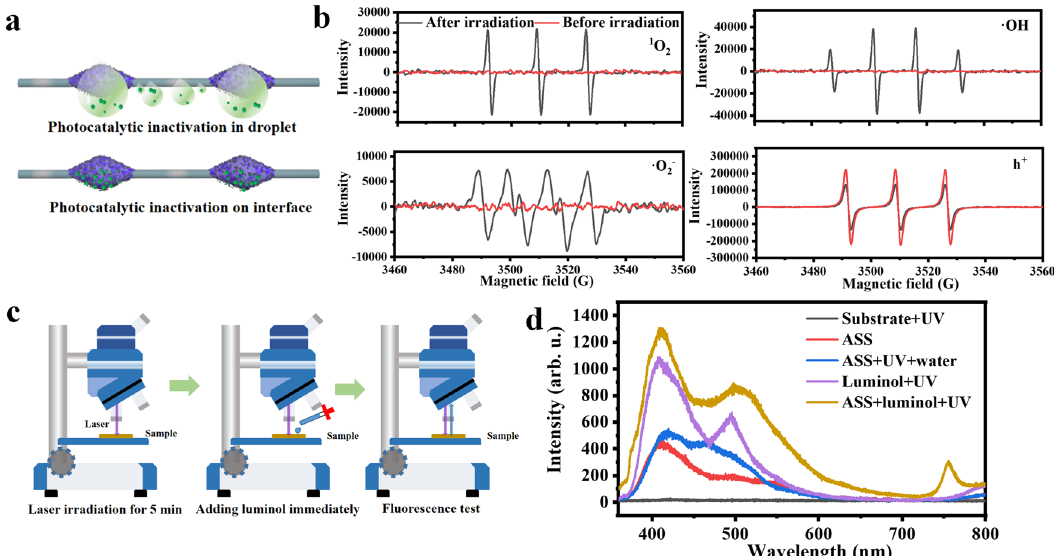
Fig. 5 | Bioaerosols inactivation mechanisms of the ASS photocatalyst. a Illustration of the two states of the bacteria on the ASS photocatalyst. b EPR spectra of 1 O 2 , h + , O 2 - and ·OH. c Illustration of the Raman-chemiluminescence test oftheASSphotocatalyst. d Chemiluminescencespectraofluminoldroppingonthe